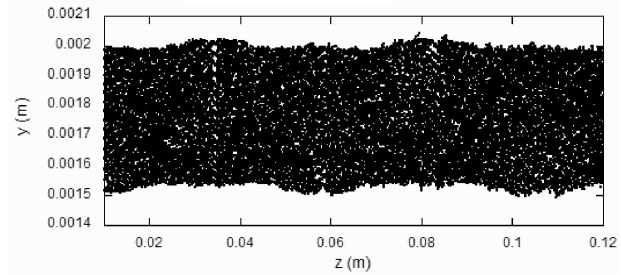
FIG. 7. PIC simulation of the nominal transport in a wiggler field